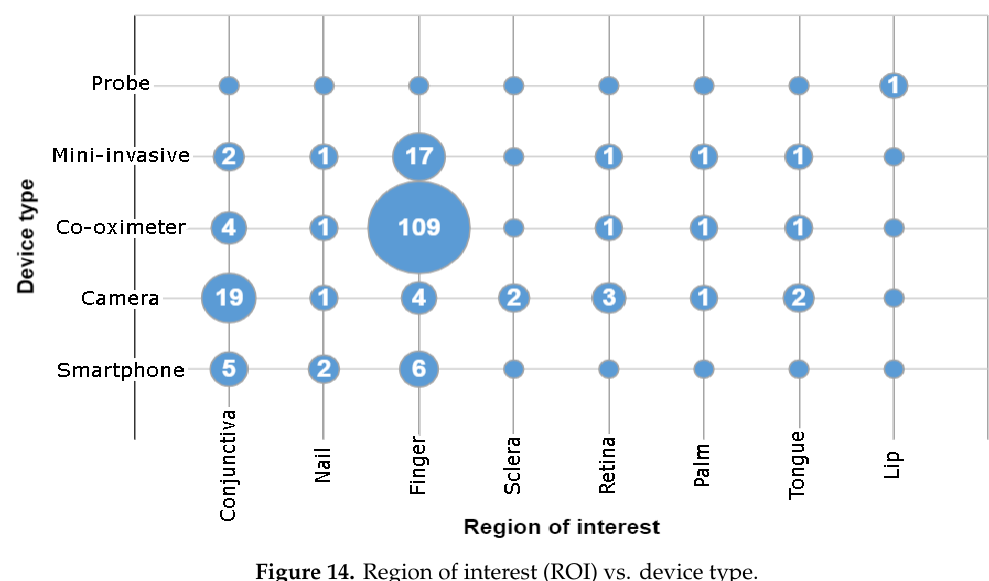
Figure 13. Region of Interest over Years.